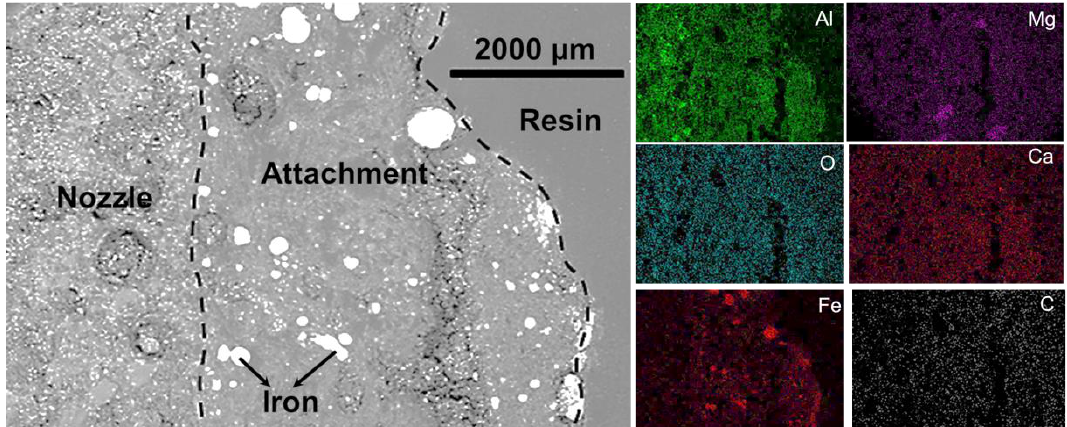
Figure 4. Materials composition from inside wall of the SEN contacting the flowing molten steel to the original matrix of the SEN.